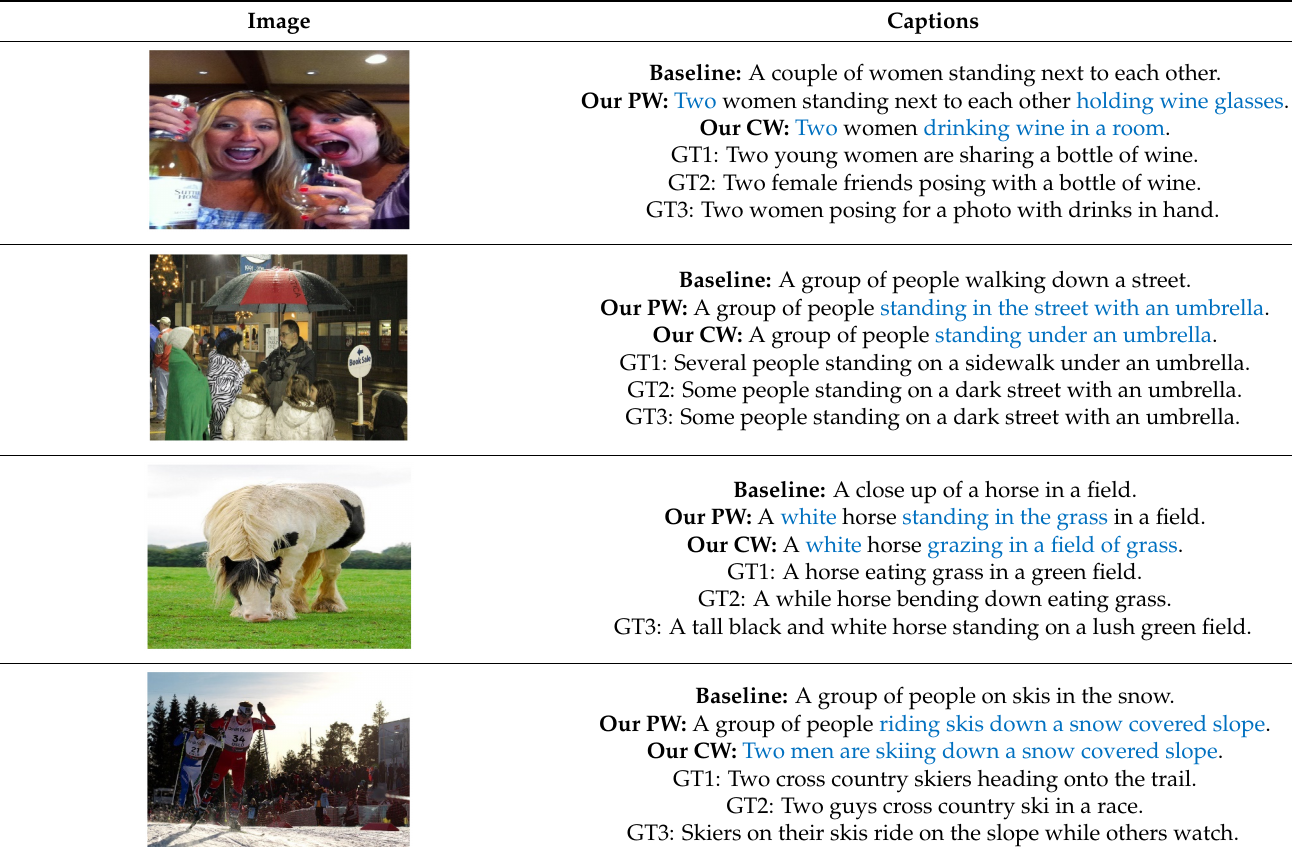
Table 4. Samples of image captions generated by our PW, CW, and baseline as well as ground truths.